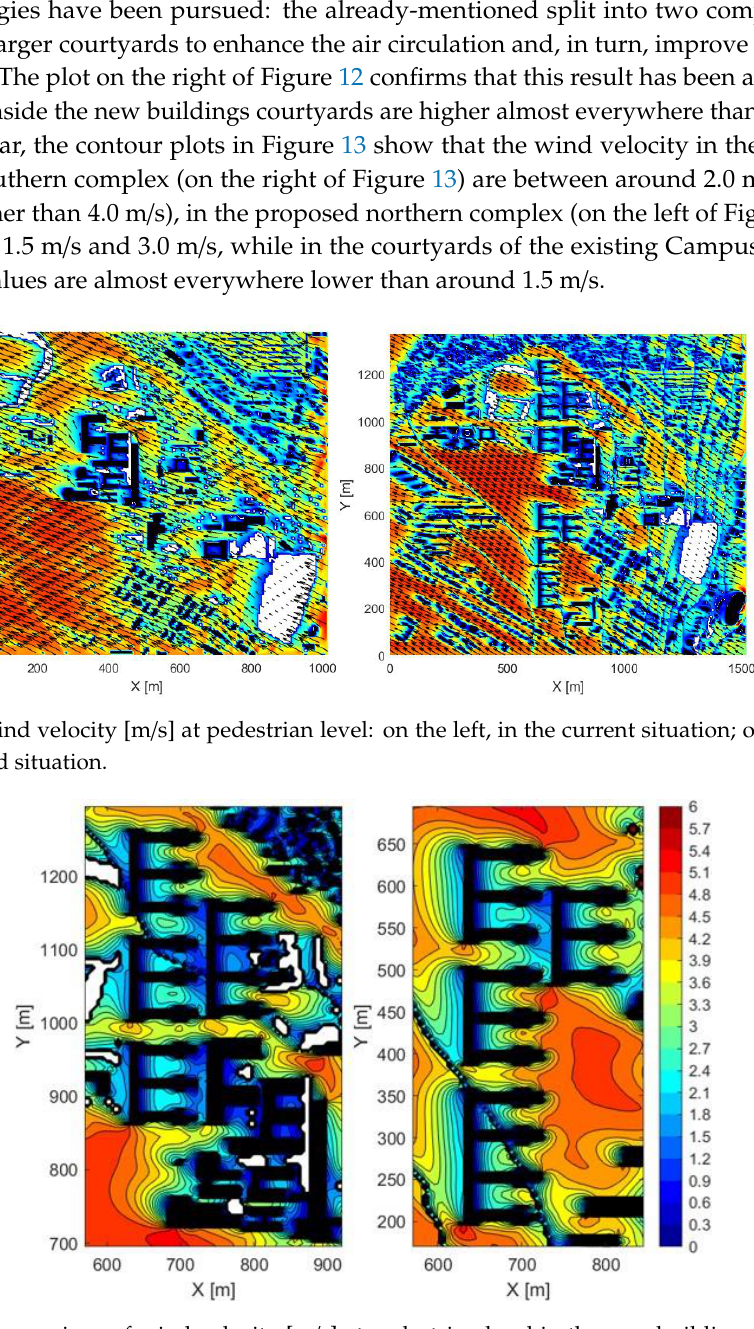
Figure 13. Comparison of wind velocity [m/s] at pedestrian level in the new buildings and in the existing ones: on the left, the northern complex of proposed buildings with the old Campus; on the right, the southern complex of proposed buildings.